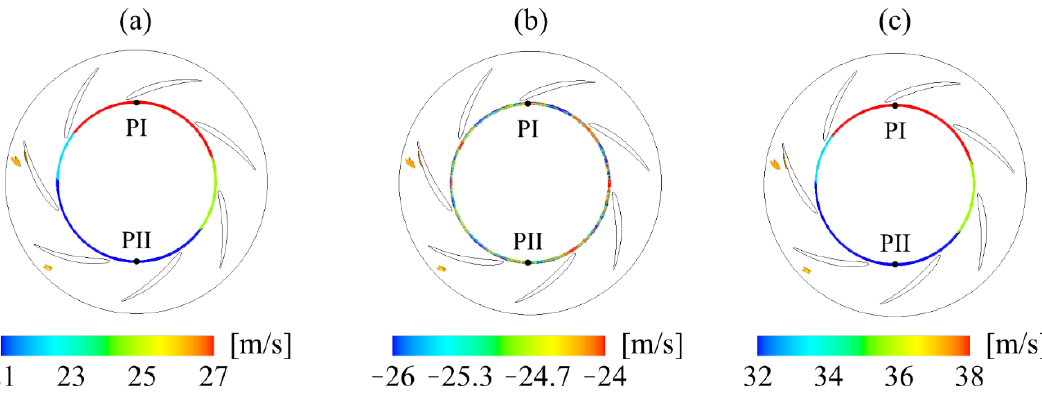
Figure 10. Transient iso-surfaces of p = 340 Pa (colored orange) and transient velocities at the gap: ( a ) tangential velocity, | v T | , ( b ) axial velocity, and ( c ) velocity magnitudes. PI and PII show the locations of the monitor points placed in the gap.